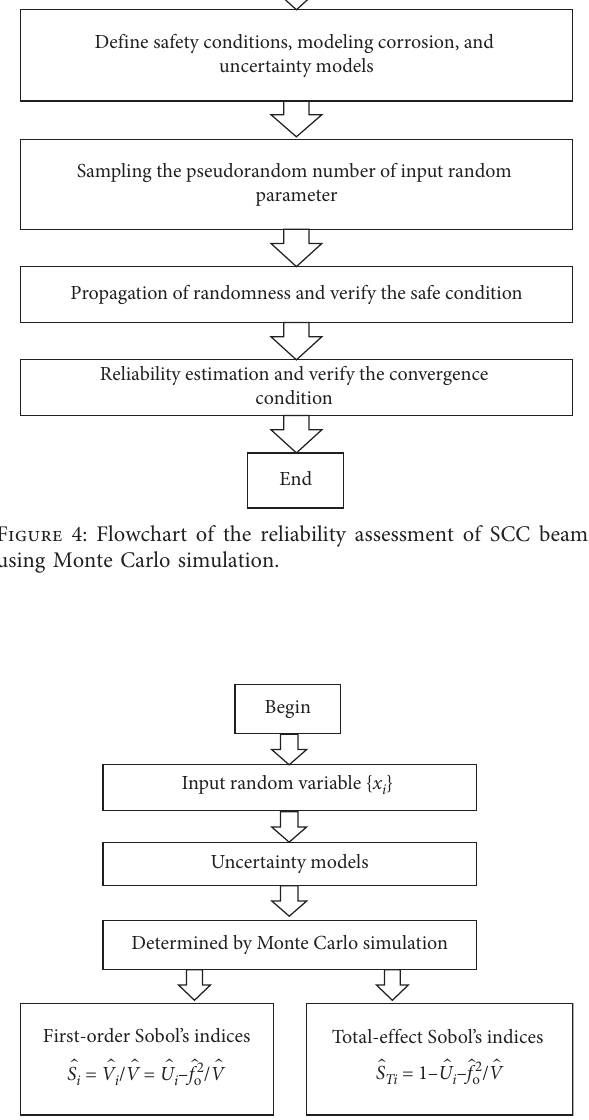
Figure 5: Flowchart of Sobol’s indices sensitivity analysis by Monte Carlo